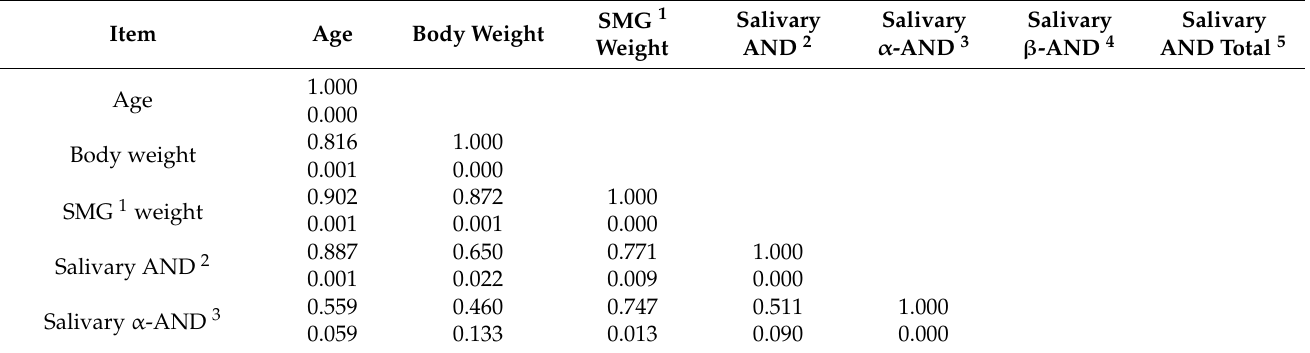
Table 2. Correlation coefficients between studied